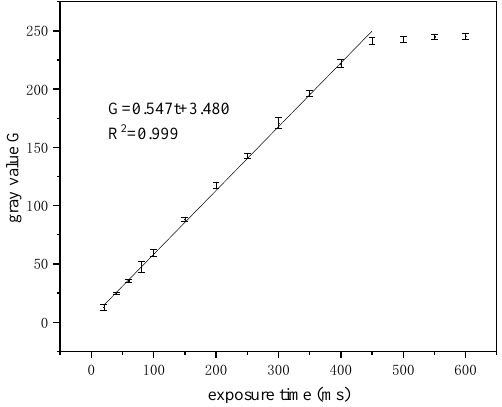
Figure 1. Relationship between the image gray value and exposure time.